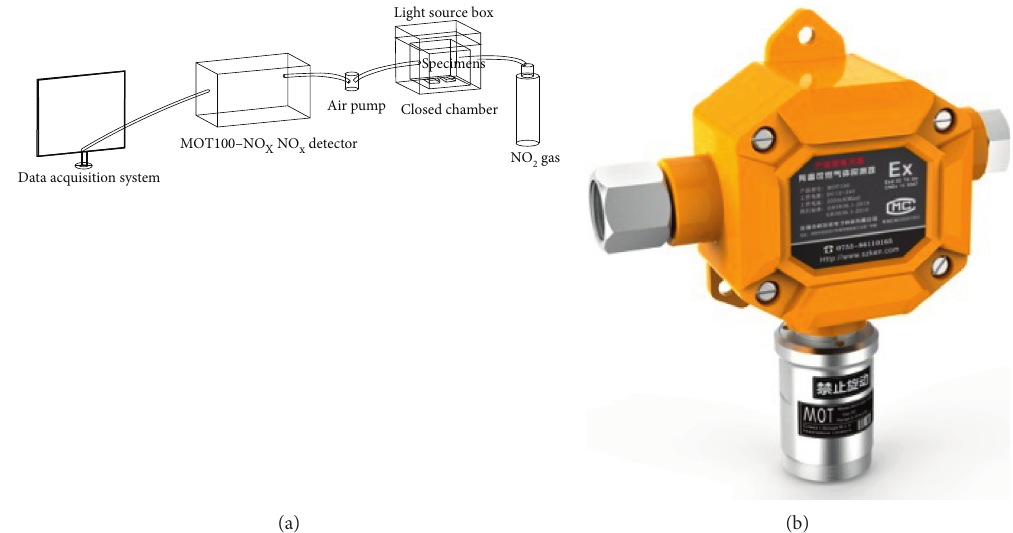
Figure 1: Experimental setup. (a) Schematic representation of the experimental setup. (b) MOT100-NO